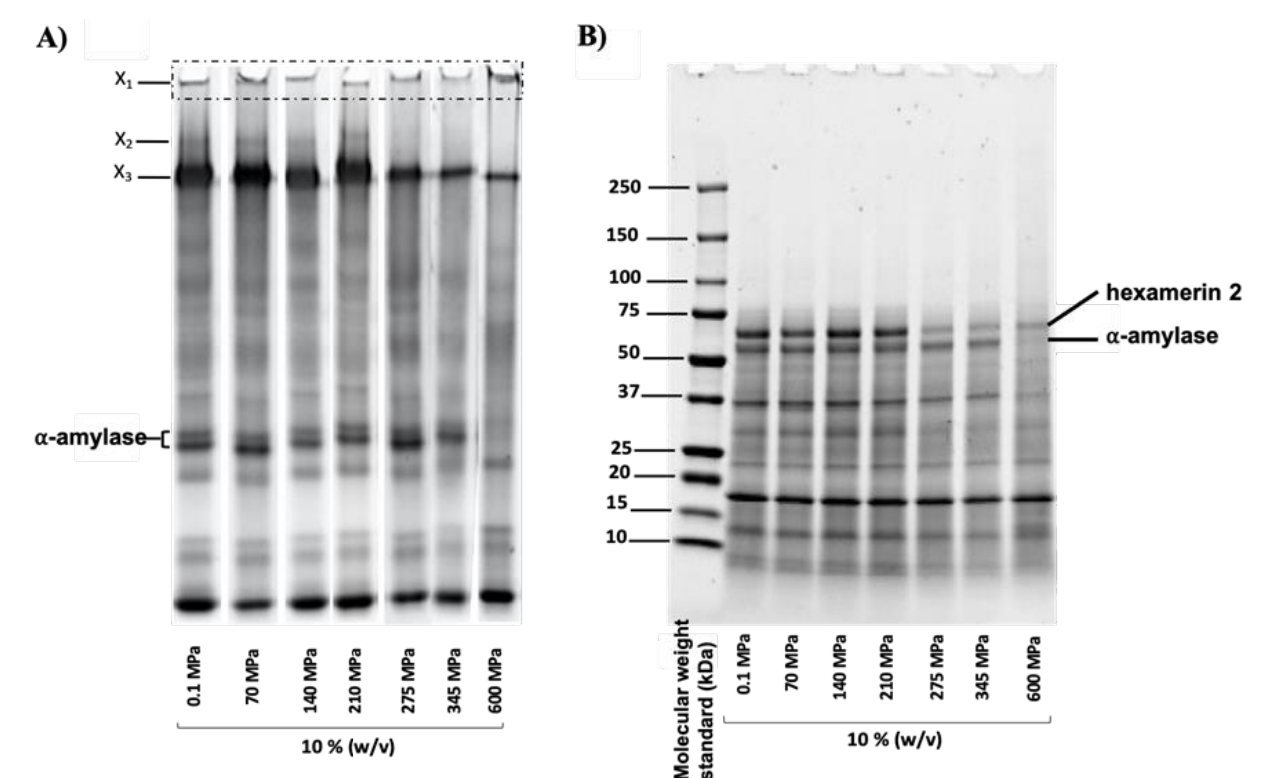
Figure 5. Native ( A ) and denatured/reduced ( B ) PAGE of control (0.1 MPa) and pressure-treated mealworm proteins. The proteins composing bands X 1 and X 2 , as well as α -amylase and hexamerin 2, were identified by proteomic analysis. Table 2. Proteomic analysis of native PAGE wells (X 1 ) of control (0.1 MPa) and HHP-treated (600 MPa) mealworm protein solutions.